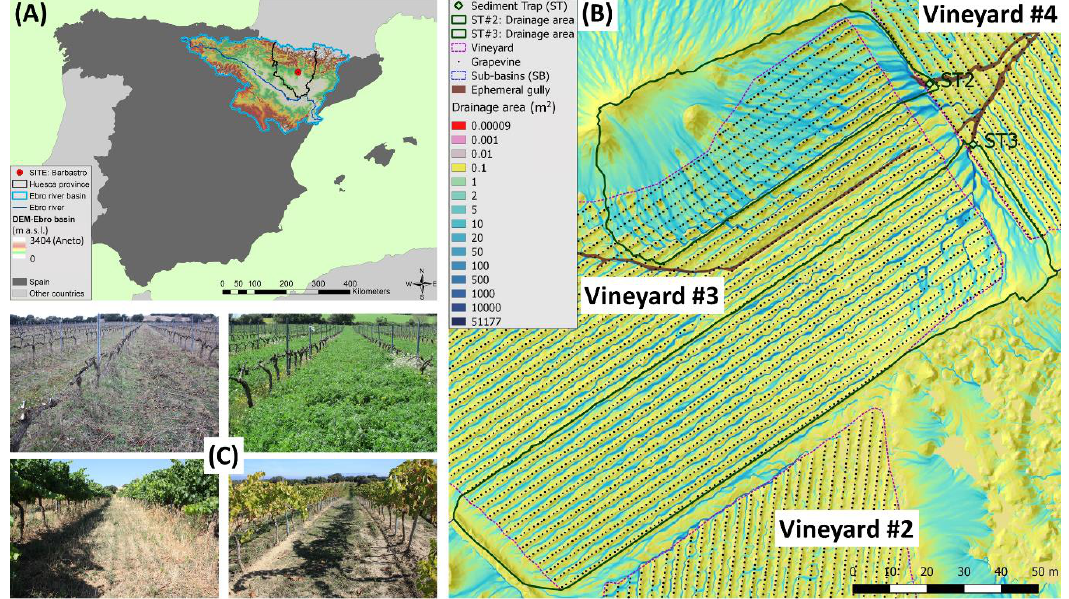
Figure 1. ( A ) Map of the overland flow pathways in the part of Los Oncenos sub-catchment where the drainage area of the two sediment traps are located, showing the location of the vines and soil sampling points ( B ). Pictures in January, April, July, and October ( C ).